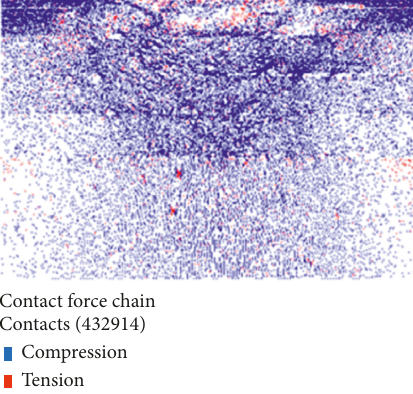
TensionContact force chain Contacts (432914) Compression Figure 15: Internal force chain diagram of the whole model.